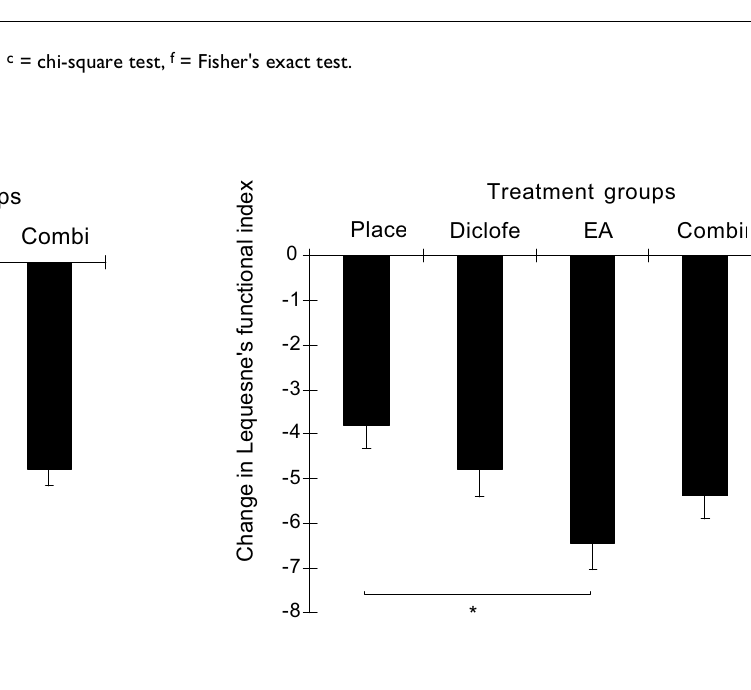
Figure 2 Change in 100 mm VAS in each treatment group evaluated at the end of week 4. Values are mean ± SEM. * = p < 0.05 between groups (one-way ANOVA and Scheffe method).